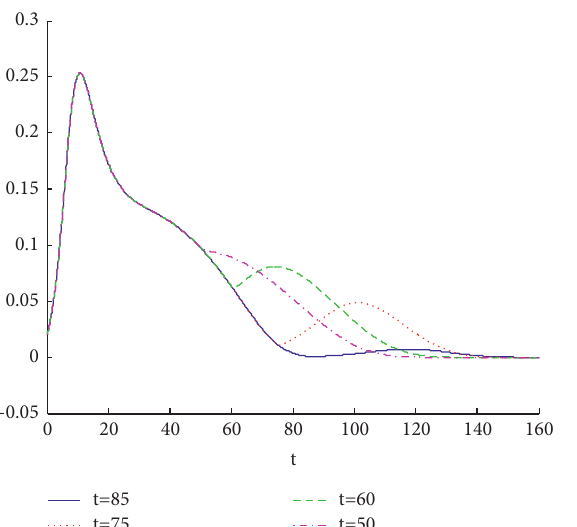
Figure 10: The change in the population density curve of the spread netizens at different secondary diffusion